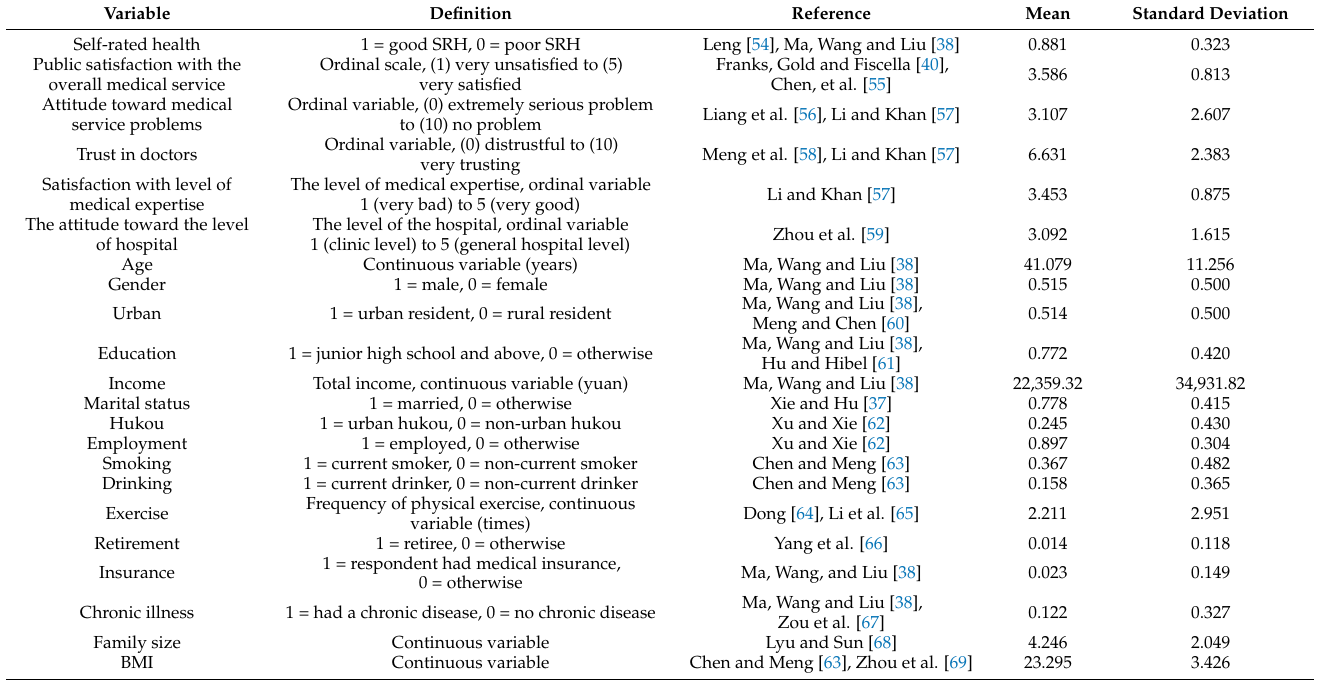
Table 1. Summary of the baseline factors assessed in this